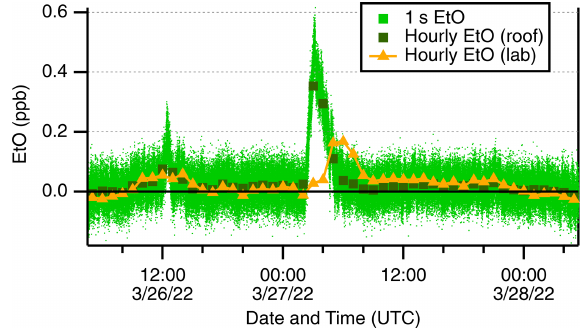
Figure 4. Ethylene oxide events measured on the rooftop inlet. Out- door data at 1s (pale green) are shown alongside hourly averages (dark green squares). Laboratory air sampled prior to autoback- grounds (orange triangles) is